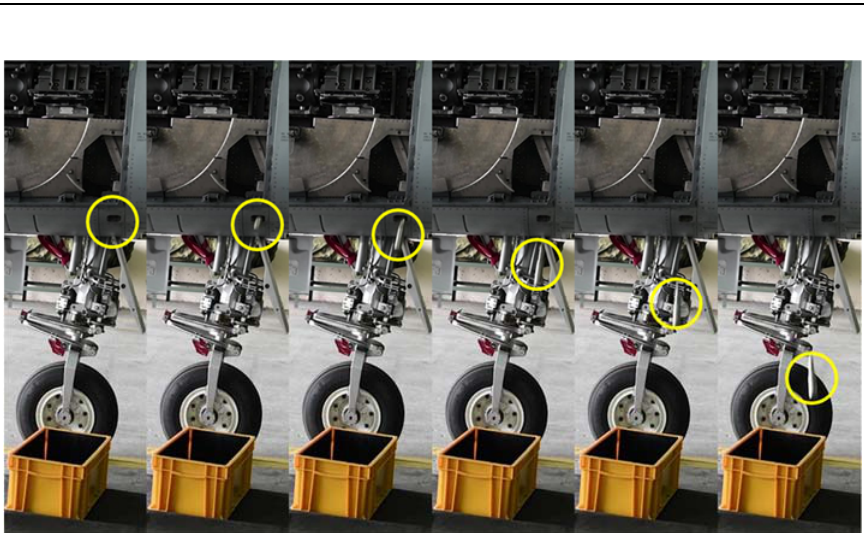
Figure 4. Dummy shell ejected from a single ‐ seater fighter aircraft on ground.